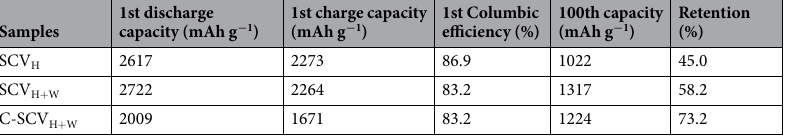
Table 2. Electrochemical properties of SCV H , SCV H + W and C-SCV H + W conducted at 200 mA g − 1 between 0.002 V to 1.5 V. The specific capacity was calculated based on the mass of active materials.